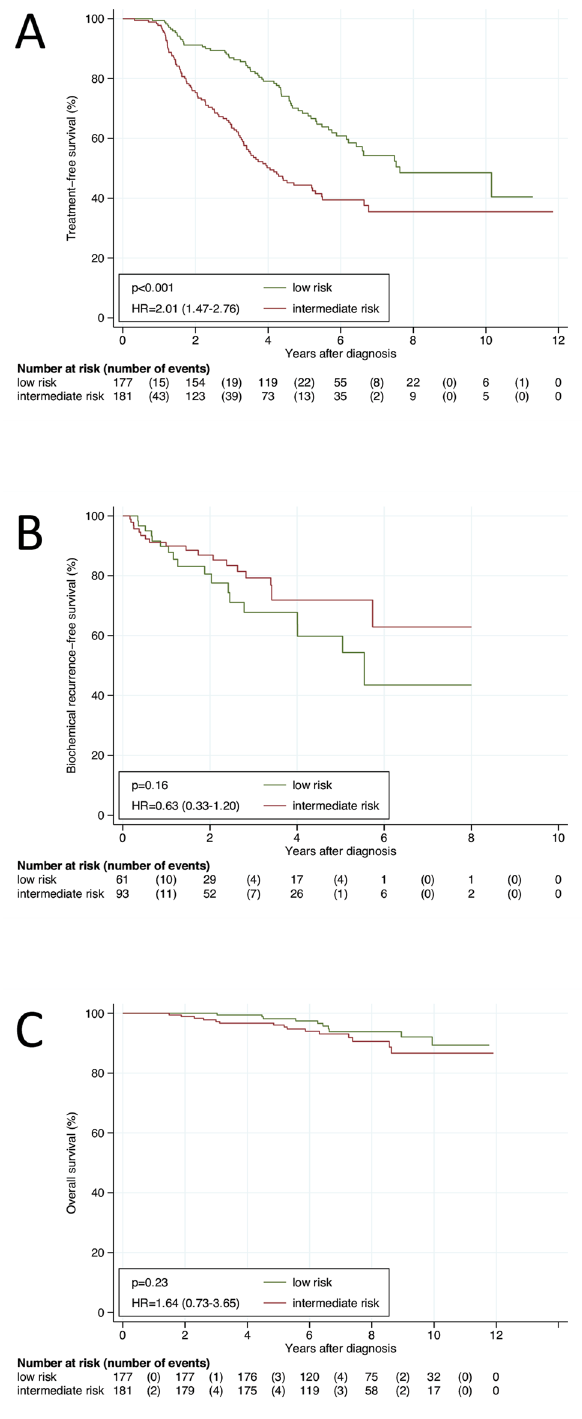
Figure 3. Kaplan–Meier plots of ( A ) treatment-free survival, ( B ) biochemical recurrence-free survival and ( C ) overall survival stratified by low-risk and intermediate-risk group at